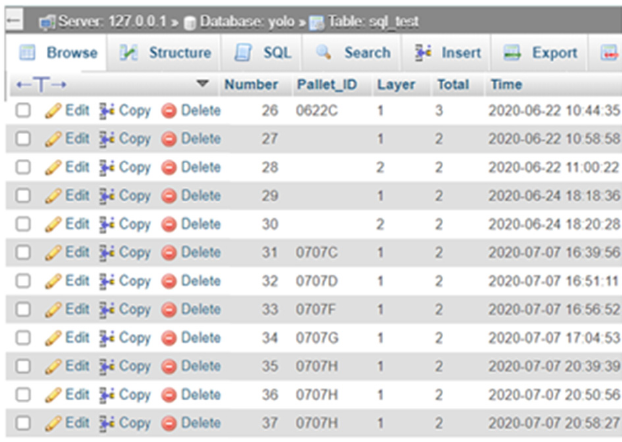
Figure 33. Palletizing data.